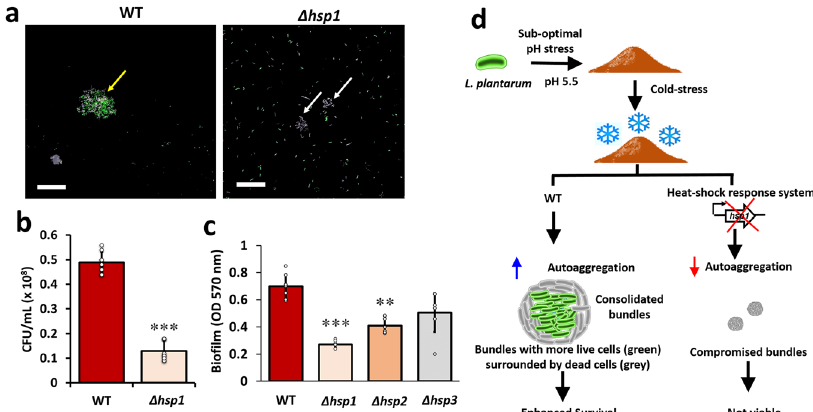
Fig. 3 The heat-shock proteins are involved in cold shock stress response. a Consolidated bundles of wild-type L. plantarum WCFS1 or hsp1 mutant ( Δ hsp1 ). Scale bar: 20 µm. The cells stained with PI (true-colour: red) are false-coloured with grey. Yellow arrow indicate consolidated bundles and white arrows indicate compromised bundles. b Colony-forming units (CFUs) of wild-type L. plantarum WCFS1 or hsp1 mutant following exposure to frozen stress. The cells were grown on MRS hard agar pH 5.5 for 7d and transferred to cold stress conditions ( − 17 °C) for 1 h. After incubation, the colonies were resuspended in phosphate-buffered saline (PBS), vortexed, diluted, and plated on fresh MRS agar plates. The graph shows the means ± SEMs of 9 individual data points, obtained from three independent measurements. *** P < 0.001 vs. the non-treated controls. c Crystal violet quanti fi cation of bio fi lms formed by L. plantarum WCFS1, and hsp mutants ( Δ hsp1, Δ hsp2 , or Δ hsp3 ) on polystyrene surface. The cells were incubated at 37 °C for 24 h without shaking, following which the cells were stained with 0.4% crystal violet and read at OD 595 . The graph shows the means ± SEMs 6 individual data points, obtained from two independent measurements. *** P < 0.001 vs. the non-treated controls. Here cells grown at pH 5.5 are taken as a control. d Mechanistic fl owchart depicting the involvement of heat- shock protein response in governing the multifaceted traits manifested by L. plantarum in response to